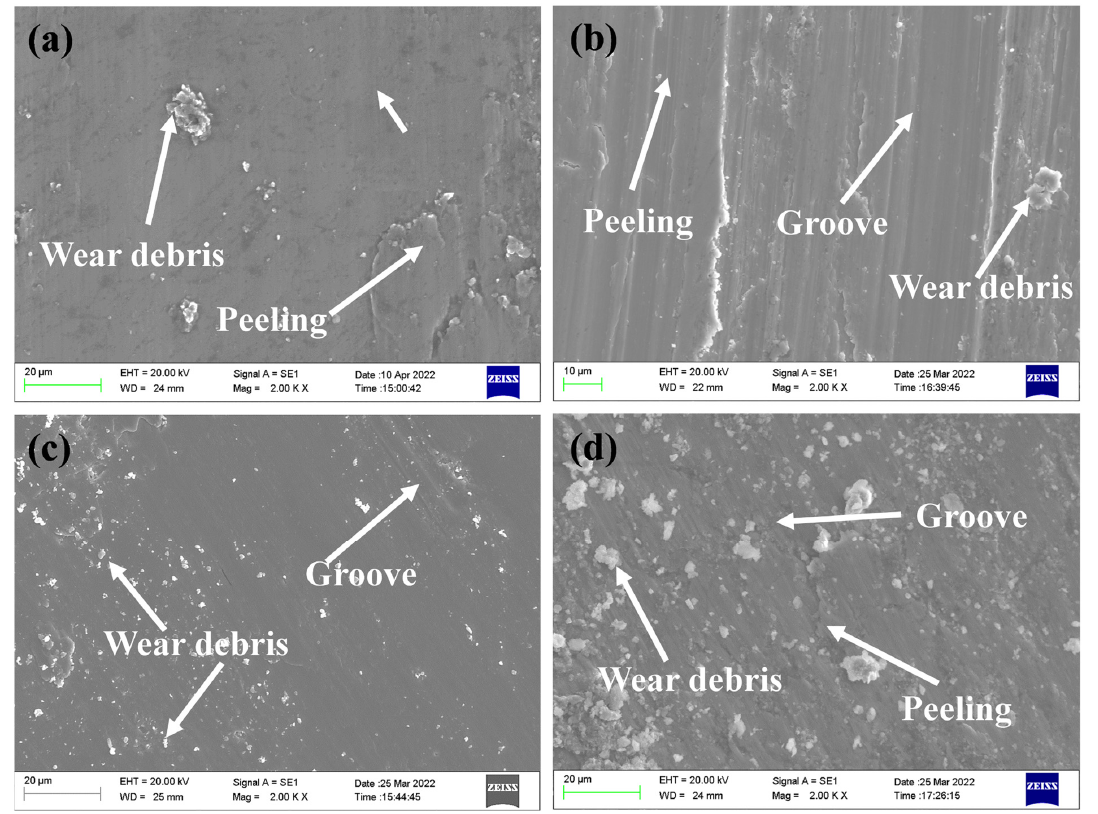
Figure 6. Wear morphologies of the coating at ( a ) room temperature and ( b ) 400 °C, and wear morphologies of the TC4 alloy at ( c ) room temperature and ( d ) 400 °C.